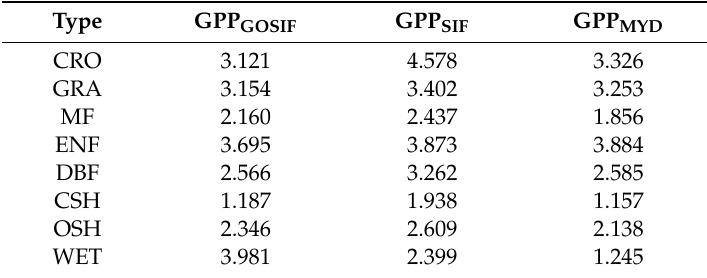
Table 5. Statistical comparisons of the GPP GOSIF -GPP EC , GPP SIF -GPP EC , and GPP MYD -GPP EC models from 2015 to 2017 for di ff erent vegetation types. Parameters: RMSE. The units are gCm − 2 day − 1 . Type GPP